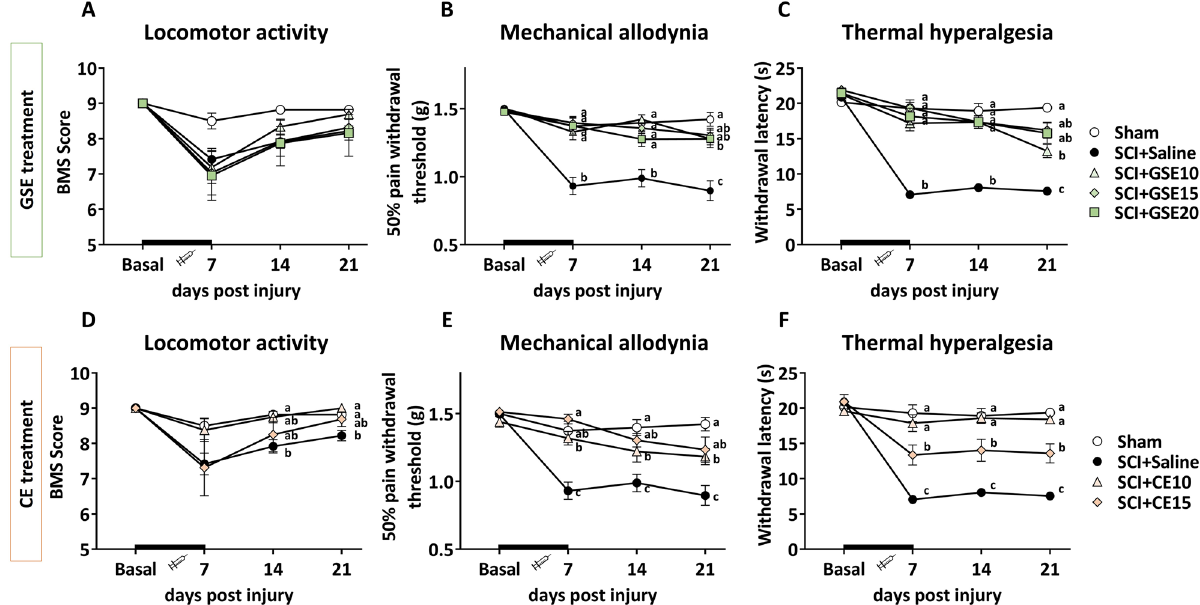
Figure 3. Time-course assessment of locomotor activity ( A , D ), mechanical allodynia ( B , E ) and thermal hyperalgesia ( C , F ) during the injury acute phase of SCI after preventive GSE and CE treatments. Each point and vertical line represent the mean ± SEM. The treatment administration week (basal to 7 dpi) is highlighted with a thick black line. a–c: Groups not sharing a letter showed significant differences, p < 0.05. Experimental groups: Sham (n = 11), SCI + Saline (n = 18), SCI + GSE10 (n = 16), SCI + GSE15 (n = 14), SCI + GSE20 (n = 12), SCI + CE10 (n = 8), SCI + CE15 (n =